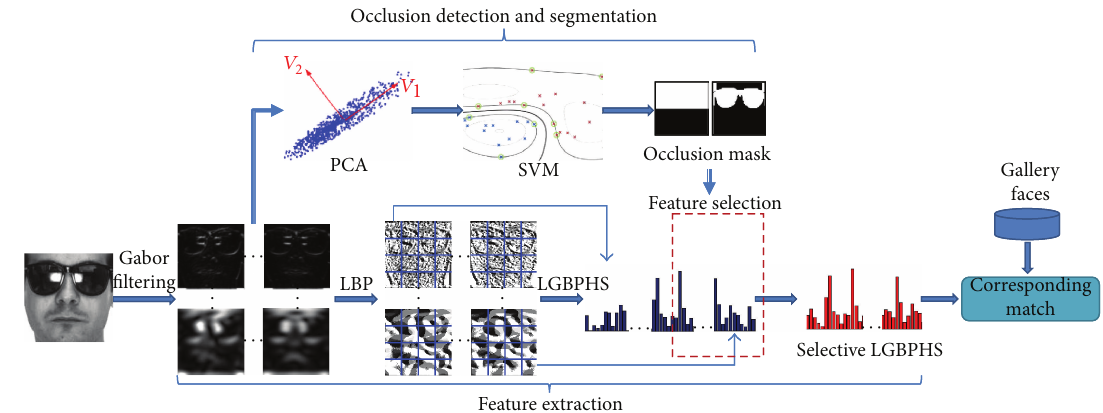
Figure 2: System